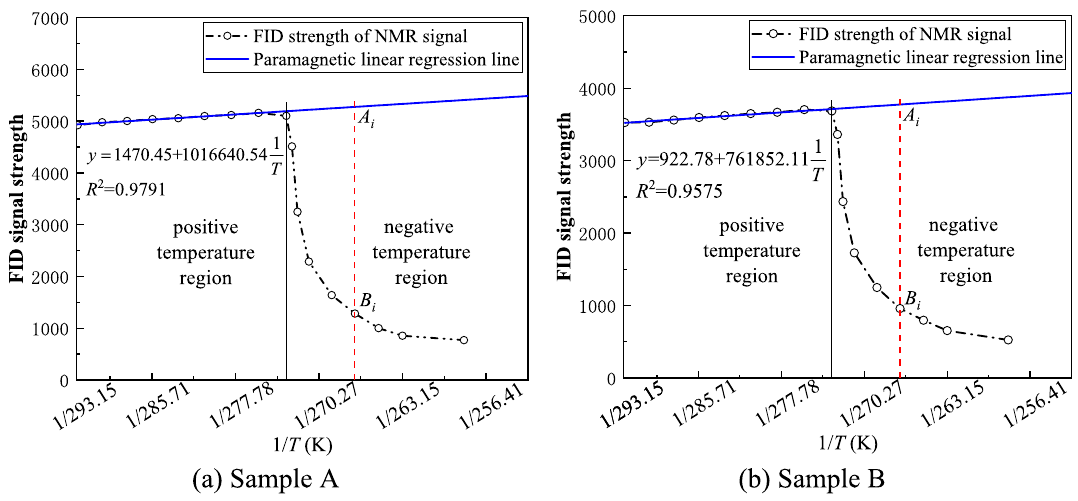
Figure 2. Variation of FID signal strength of coal samples with